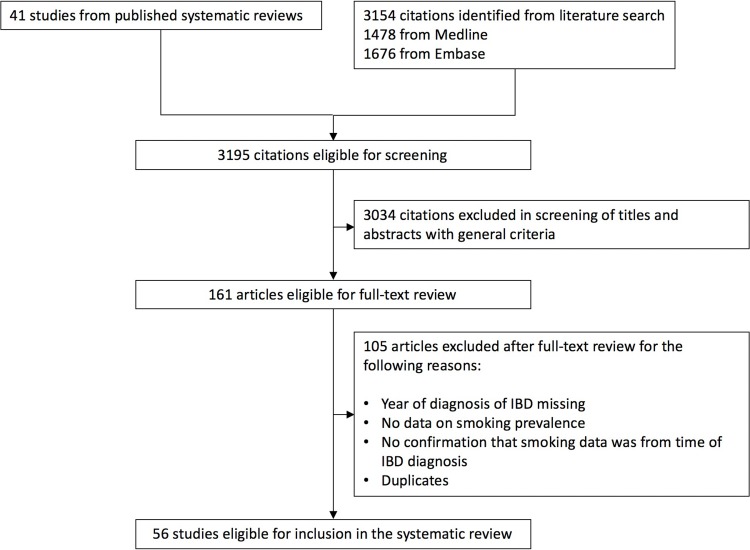
Study selection.